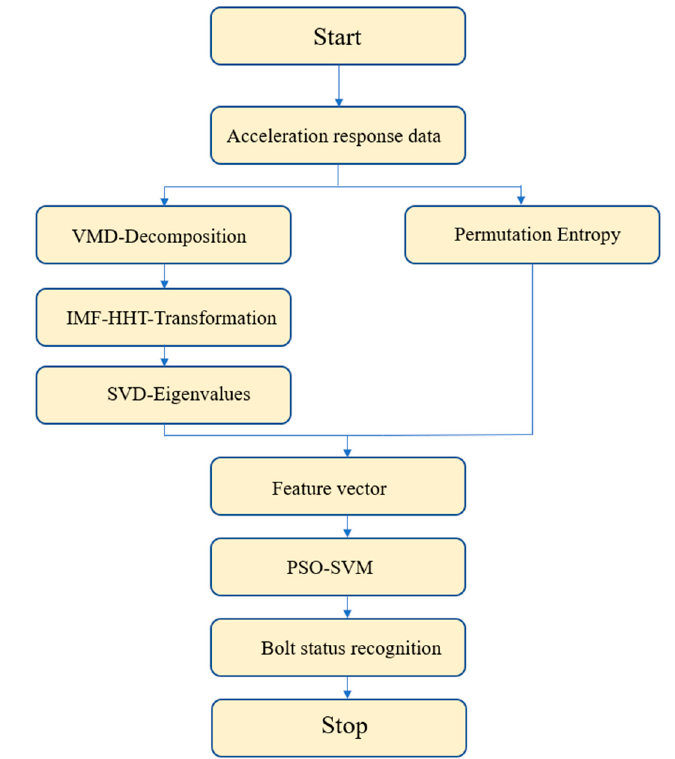
Figure 3. Identification method flow chart.